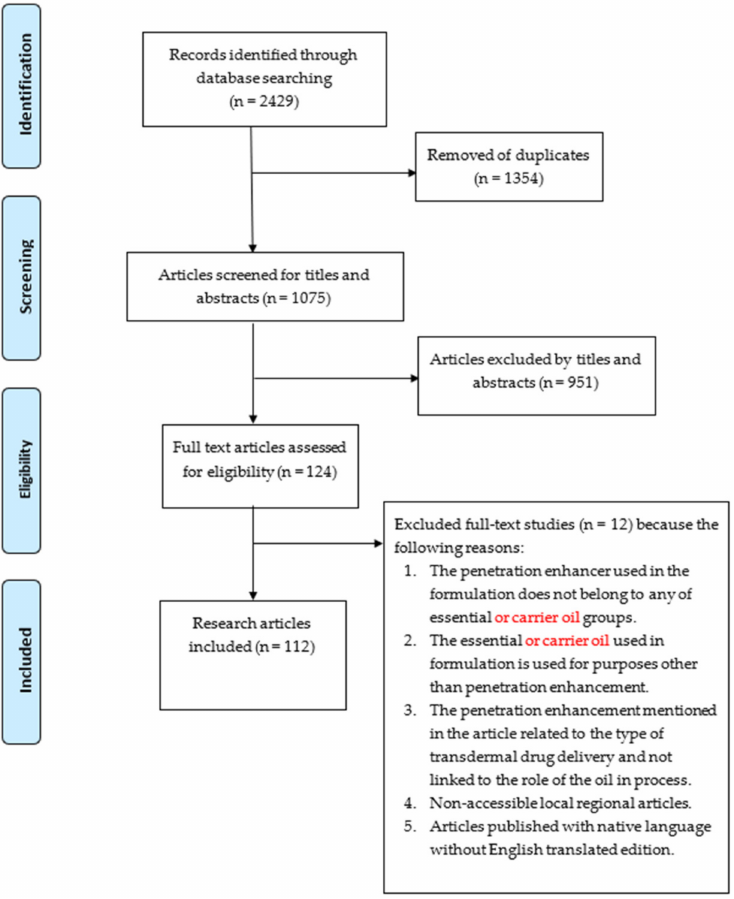
Figure 1. Flow diagram for literature search with inclusion and exclusion